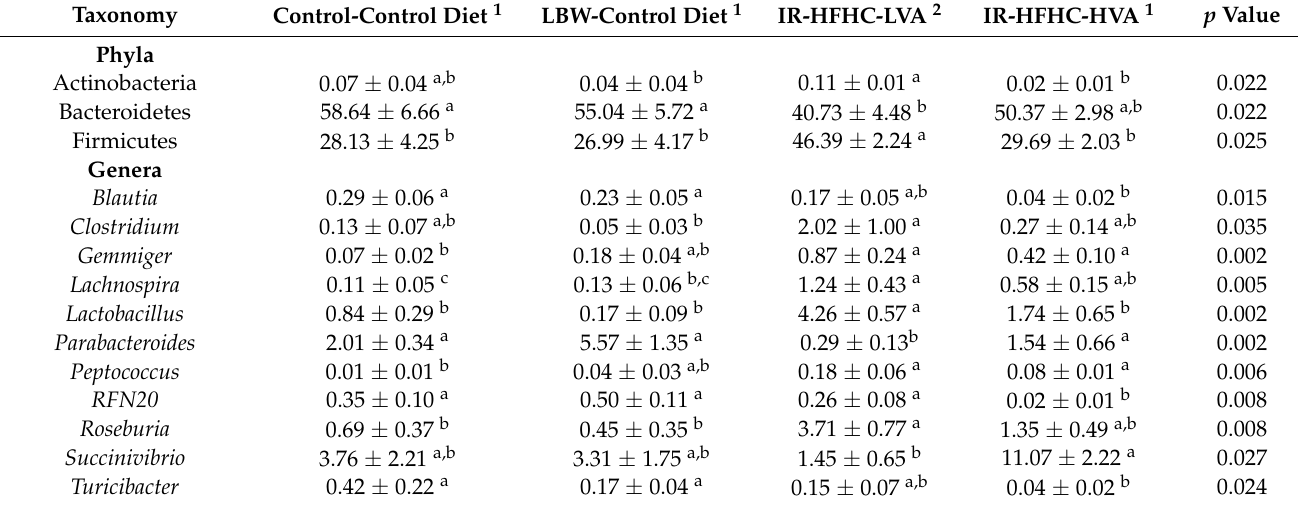
Figure 3. Principle coordinate analysis of cecal bacterial community composition using Bray–Curtis distance metrics. Distinct microbial community structure observed in IR-HFHC-LVA fed pigs was attenuated in pigs fed supplemental vaccenic acid (IR-HFHC-HVA) (ADONIS, p = 0.003). Cecal microbial composition was impacted by consumption of the IR-HFHC-LVA Table 7. Relative abundance of differing cecal taxonomy in control and LBW pigs fed control, HFHC-LVA, and HFHC-HVA diet in LBW pigs (Table 7). IR-HFHC-LVA diet intake in LBW pigs resulted in increased relative abundance of Firmicutes ( p = 0.025) and reduced Bacteroidetes (p = 0.022) when